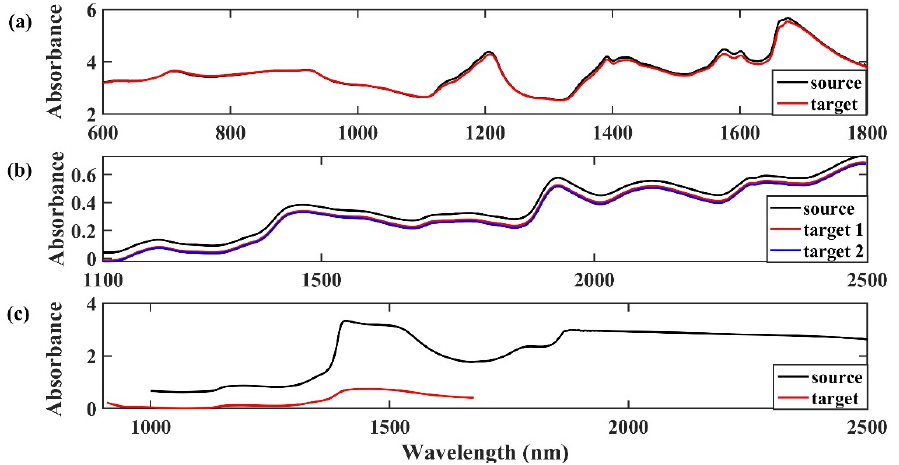
Figure 9. Typical source and target spectra of dataset 1 ( a ), dataset 2 ( b ), and dataset 3 ( c ). Dataset 2 comprised the NIR spectra of corn samples in the range of 1100–2498 nm acquired by three instruments (m5, mp5, and mp6), and can be downloaded from http://software.eigenvector.com/Data/Corn/index.html (accessed on 1 June 2005). We took m5 as the source instrument, while assigning mp5 and mp6 as the target